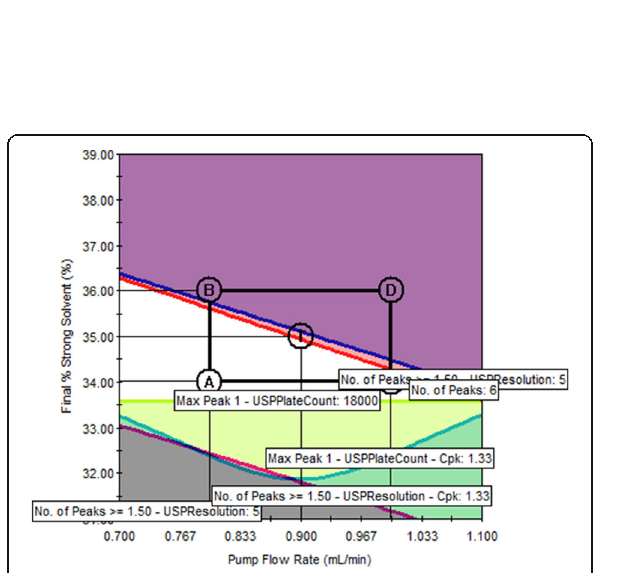
Fig. 6 Single overlay graph shows the original as-is method at point T is not robust (pump flow rate = 0.90 mL/min; final % strong solvent = 35%; oven temperature = 30 °C; EDTA concentration = 0.50 mM)